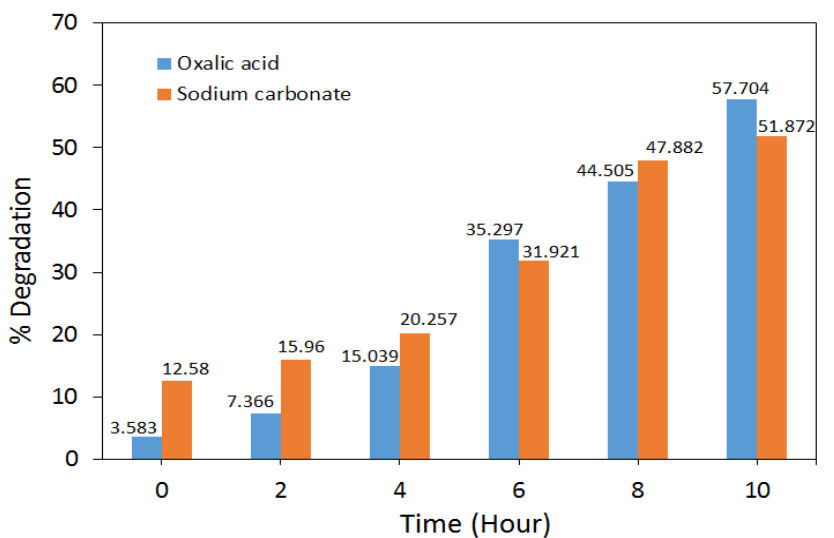
Figure 7: Photodegradation of methyl orange in presence of Bi